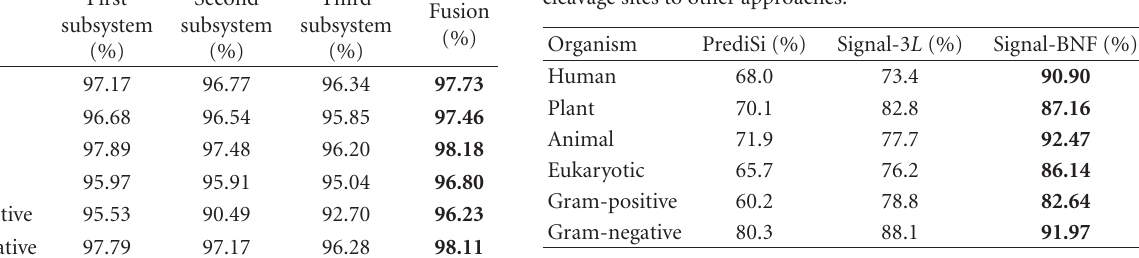
Table 11: Compare our approach’s prediction accuracy for the cleavage sites to other